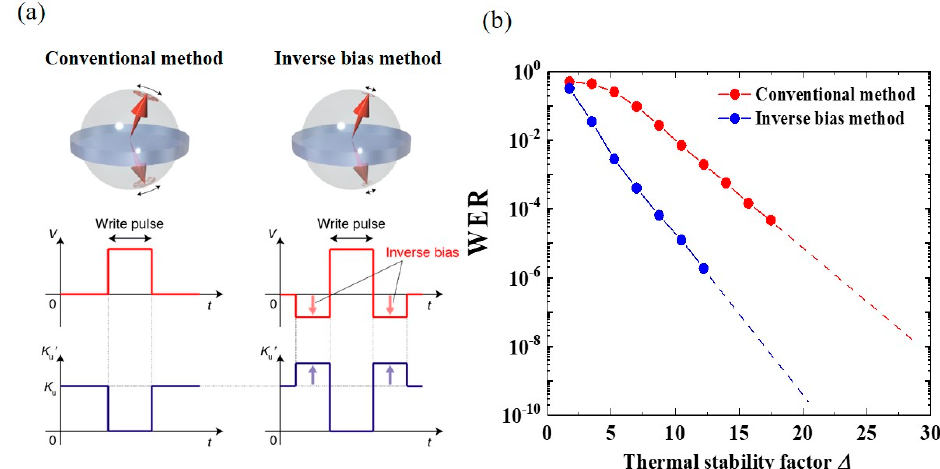
Figure 21. ( a ) Comparison of write pulse sequence in conventional and inverse bias methods. ( b ) Numerically obtained WER as a function of Δ using two different methods.